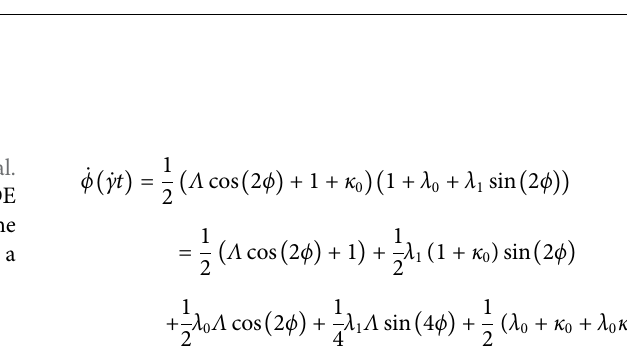
FIGURE 2 | The integration of BIOL with MSM (A) . Raw data are pre-processed (B) and then sampled for online training (C) . The learned parameters (D) allow predictions for angular speed (E) and comparison of the ground truth (blue), JOE (red), and L-JOE (green) solutions. The L-JOE theory in the right side of panel C describes the relationship between ϕ and _ ϕ TH